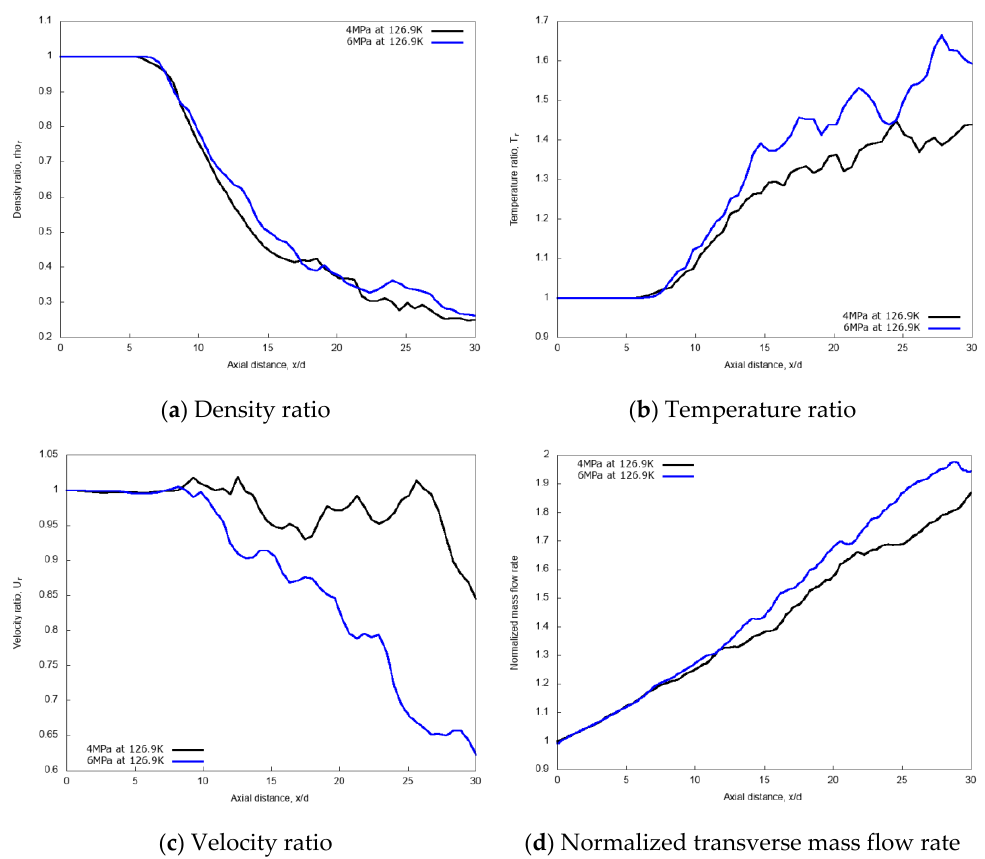
Figure 9. Centerline axial profiles of non-dimensional density, temperature, velocity, and normalized transverse mass flow rate for different chamber pressures: 4 MPa and 6 MPa. Simulations of cryogenic L-N 2 injected at 126.9 K and 4.9 m/s into G-N 2 at 298 K.